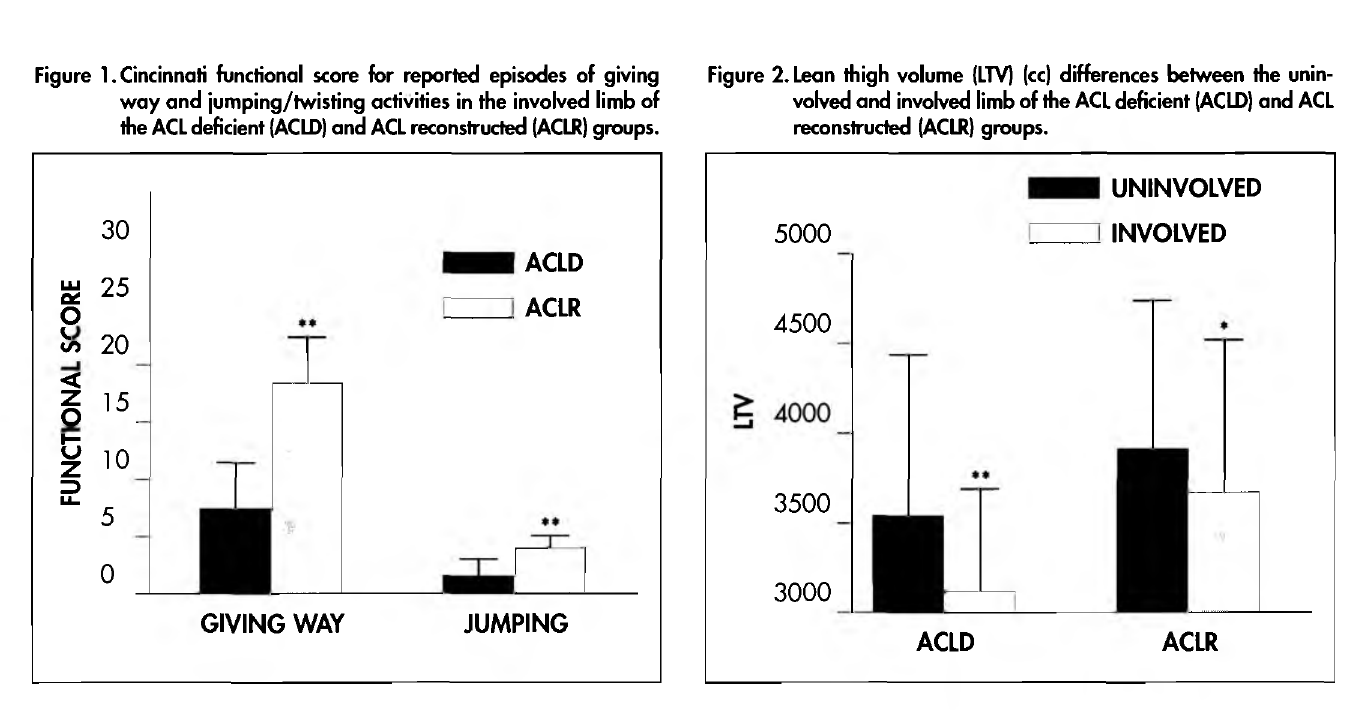
Figure 2. Lean thigh volume (LTV) (cc) differences between the unin­ volved and involved limb of the ACL deficient (ACLD) and ACL reconstructed (ACLR) groups.